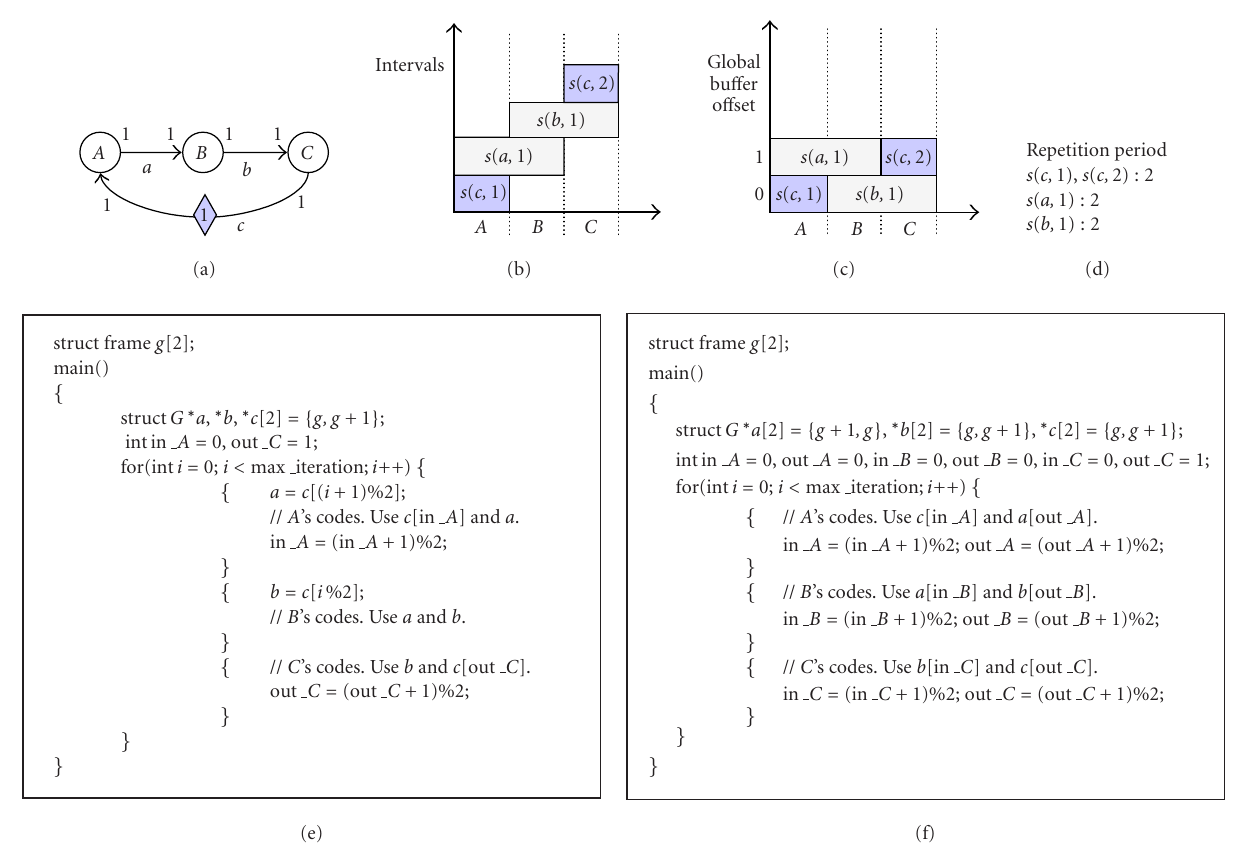
Figure 11: (a) A graph which is equivalent to Figure 3a, (b) lifetime intervals of samples for an iteration cycle, (c) an optimal global bu ff er lifetime chart, (d) repetition periods of sample lifetime patterns, (e) generated code with dynamic binding, and (f) generated code with static